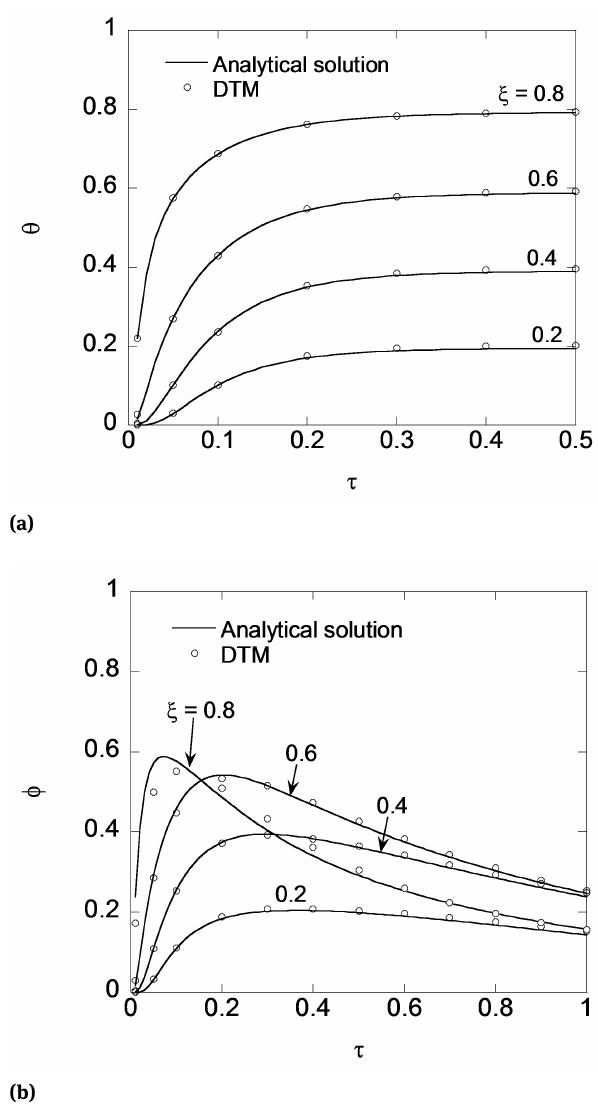
Fig. 3. Comparison of present series solutions with analytical solu- tions [13] for (A) temperature and (B) moisture at various through- thickness locations, for νλ = 0.25, L / D = 10, and ϕ ∞ = θ ∞ =